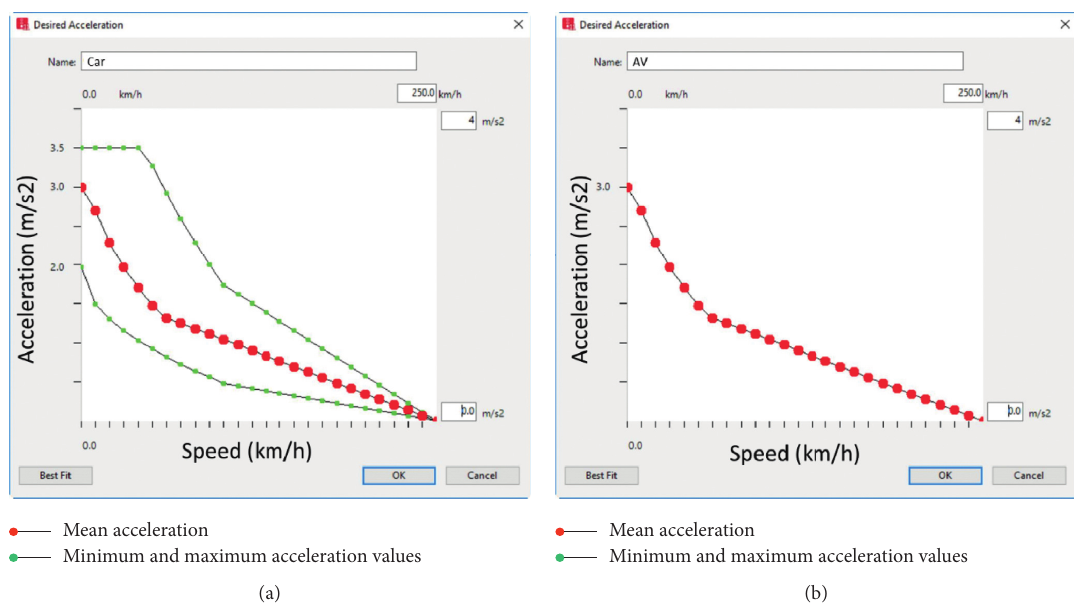
Figure 3: Desired acceleration functions of a typical car and an autonomous vehicle in Vissim [15]. (a) Typical car. (b) Autonomous vehicle.